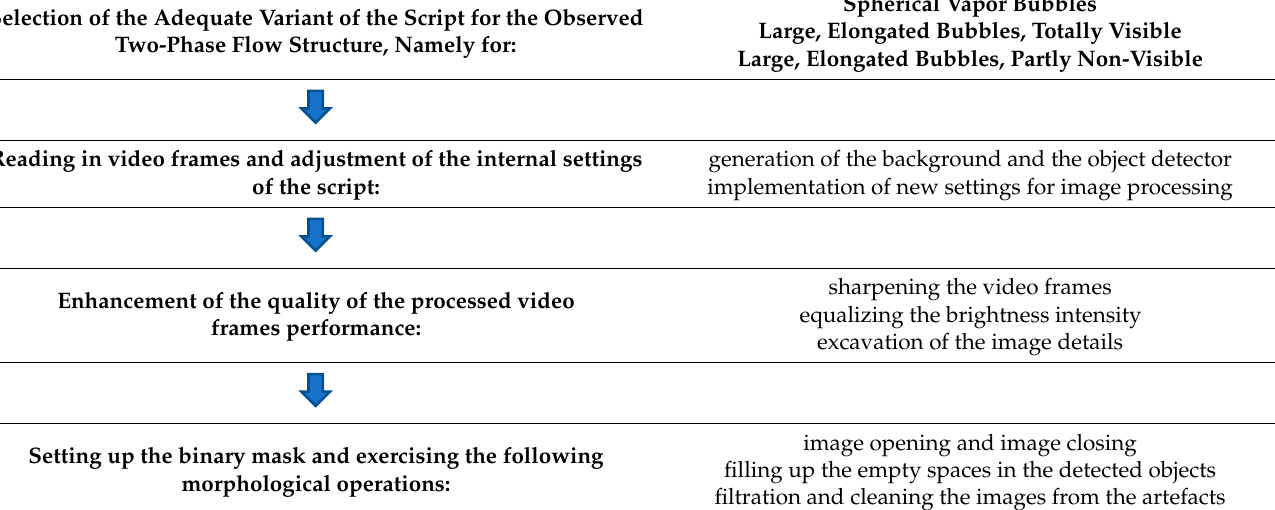
Table 1. Global scheme of the Matlab script functioning.